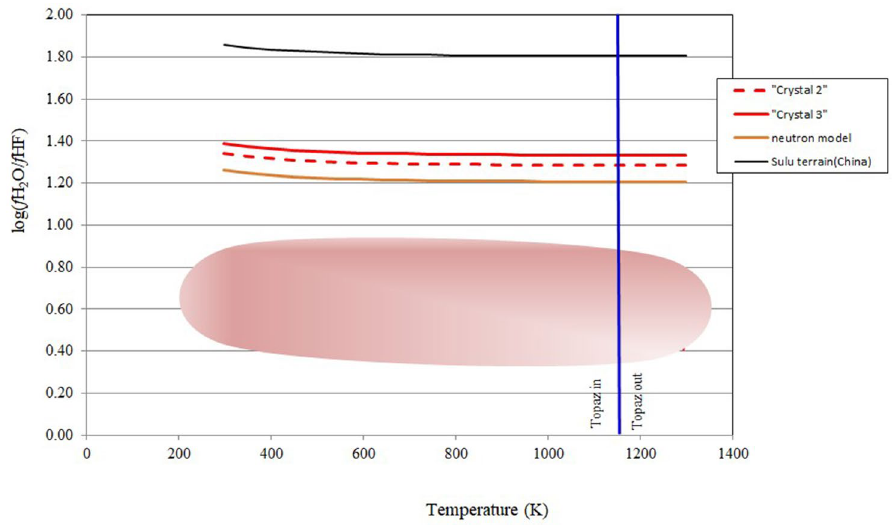
Figure 10. Log fugacity ratios versus temperature (K) plot for an inferred (pegmatite) fluid in equilibrium with PadPar topaz. Log( f H 2 O/ f HF) fluid versus T show slightly lower fugacity values at increasing temperature. Calculations using chemical analyses (red lines), and neutron diffraction model (yellow line) are reported here. Pink shadow field: log( f H 2 O/ f HF) fluid calculated on topaz sampled in various sites of the Proterozoic Eastern Brazilian Pegmatite province 23–26,56,61 ; black line: the log( f H 2 O/ f HF) fluid calculated on the OH- richest natural topaz so far recorded (from quarzites in Sulu terrane, China 1,2 ). The potential initial crystallization temperature of topaz in the PadPar pegmatite system is also